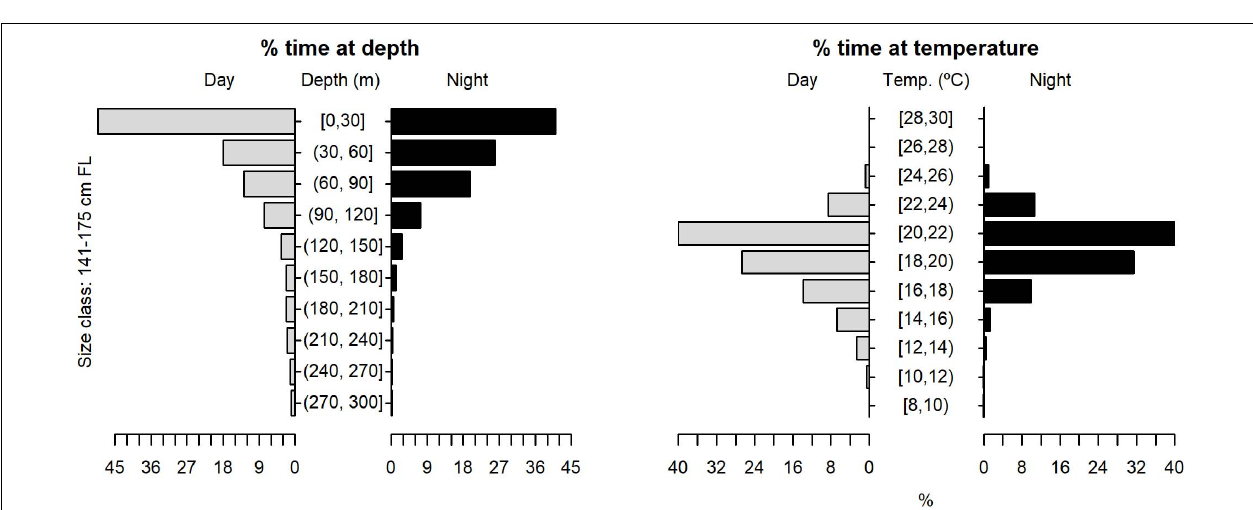
FIGURE 8 | Vertical habitat use of shortfin makos ranging in size from 110 to 140 cm FL, for daytime and night-time in terms of depth and temperature. Depth classes are categorized in 30 m intervals and temperature classes in 2 ◦ C intervals.